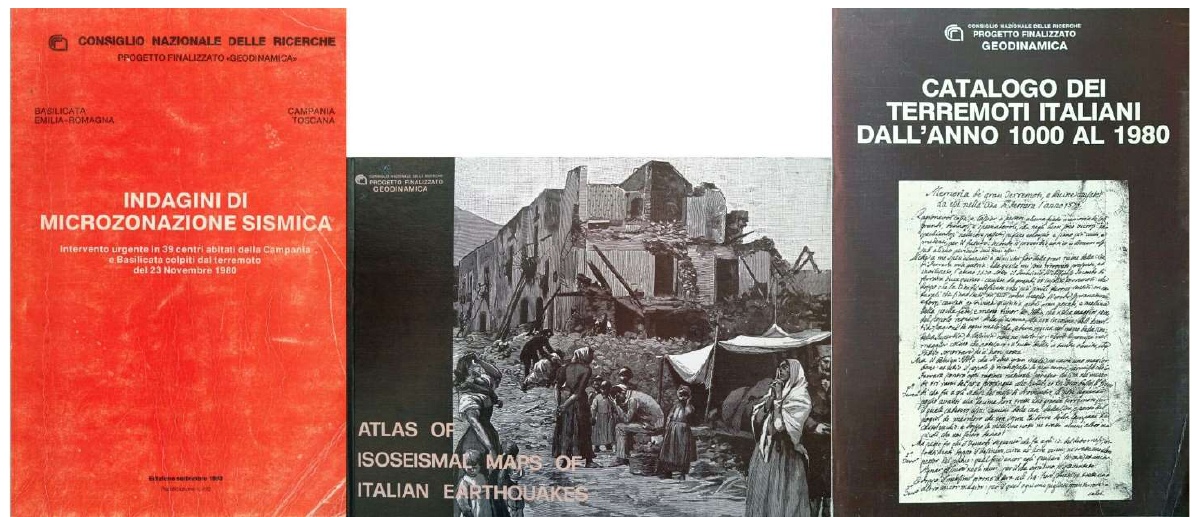
Figure 8. Some of the most important CNR-PFG publications; left, the volume of preliminary seismic microzonation studies for 39 locations severely affected by the 1980 earthquake [35]; center, the atlas collecting the isoseismal maps of the most important Italian earthquakes (1985, [36]); right, the catalogue of Italian earthquake from 1000 to 1980 of the CNR-PFG [37].